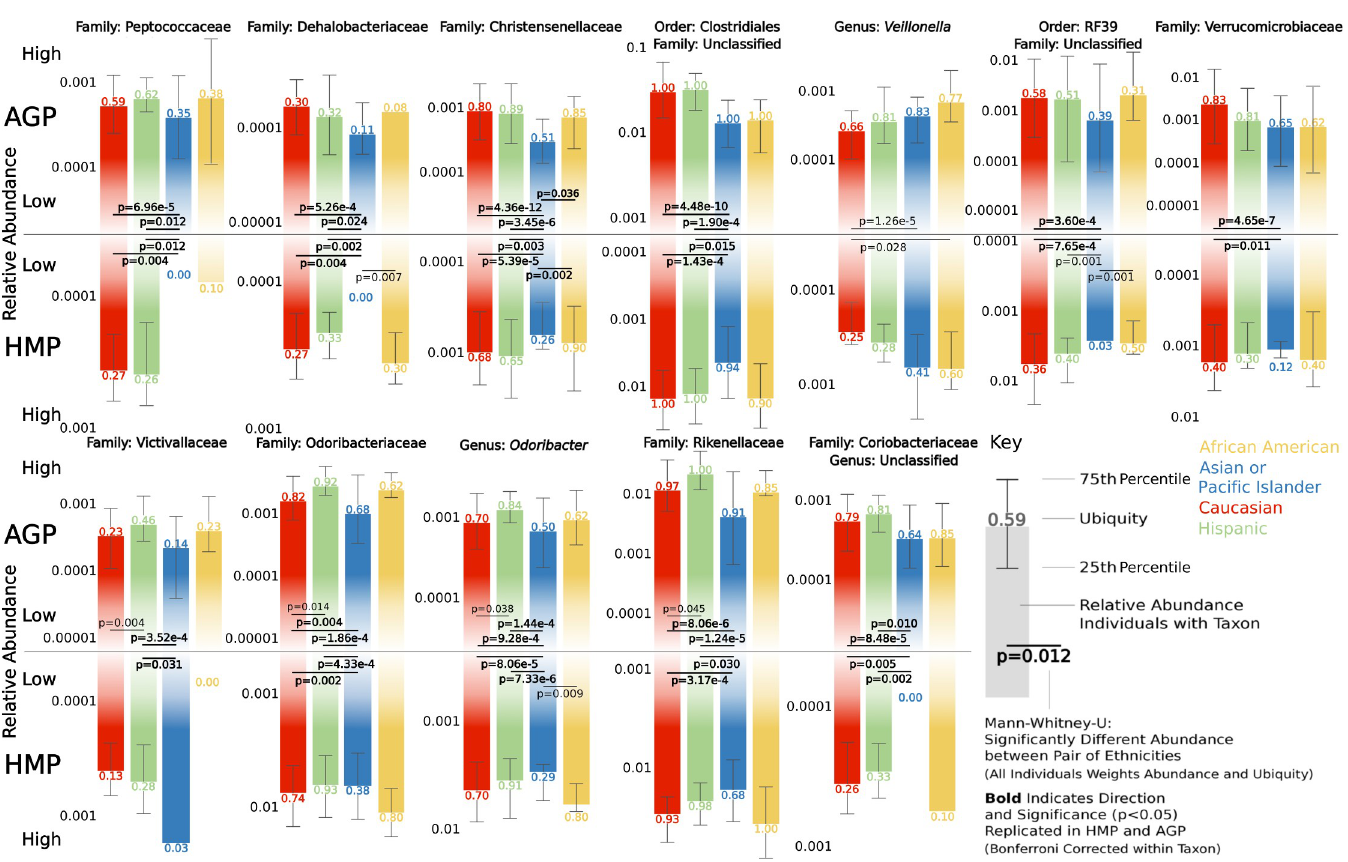
Fig 4. Ethnicity-associated taxa match between the HMP and AGP. Bar plots depict the log10 transformed relative abundance for individuals possessing the respective taxon within each ethnicity, ubiquity appears above (AGP) or below (HMP) bars, and the 25th and 75th percentiles are shown with extending whiskers. Mann–Whitney U tests evaluate differences in abundance and ubiquity for all individuals between pairs of ethnicities; for example, the direction of change in Victivallaceae is driven by ubiquity while abundance is higher for those possessing the taxon. Significance values are Bonferroni corrected for the six tests within each taxon and data set, and bold p -values indicate that significance ( p < 0.05) and direction of change replicate in the AGP and HMP. Data available at https://github.com/awbrooks19/microbiota_and_ ethnicity. AGP, American Gut Project; HMP, Human Microbiome